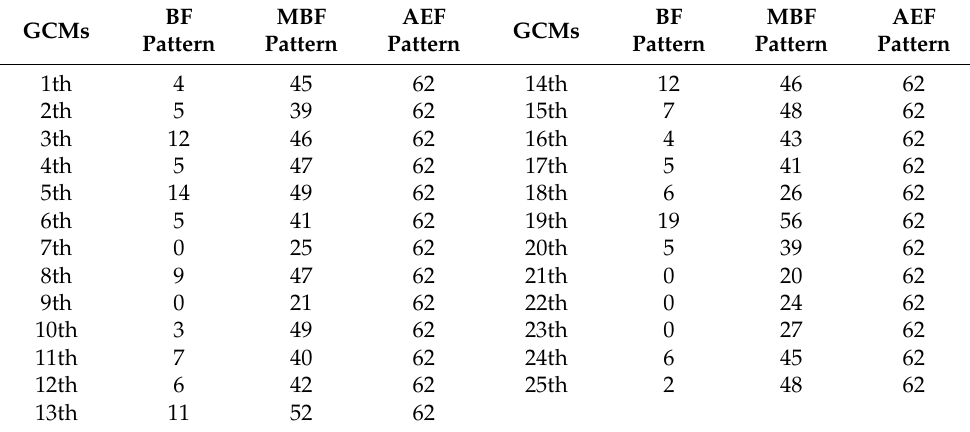
Figure 6. Water-conflict years under different EF patterns and GCMs for future periods: each red point indicate the water-conflict year (EF: environmental flow; BF: basic flow; MBF: maintenance basic flow; AEF: appropriate environmental flow). Table 2. The number of water-conflict years from the future period under different EF patterns and GCMs.